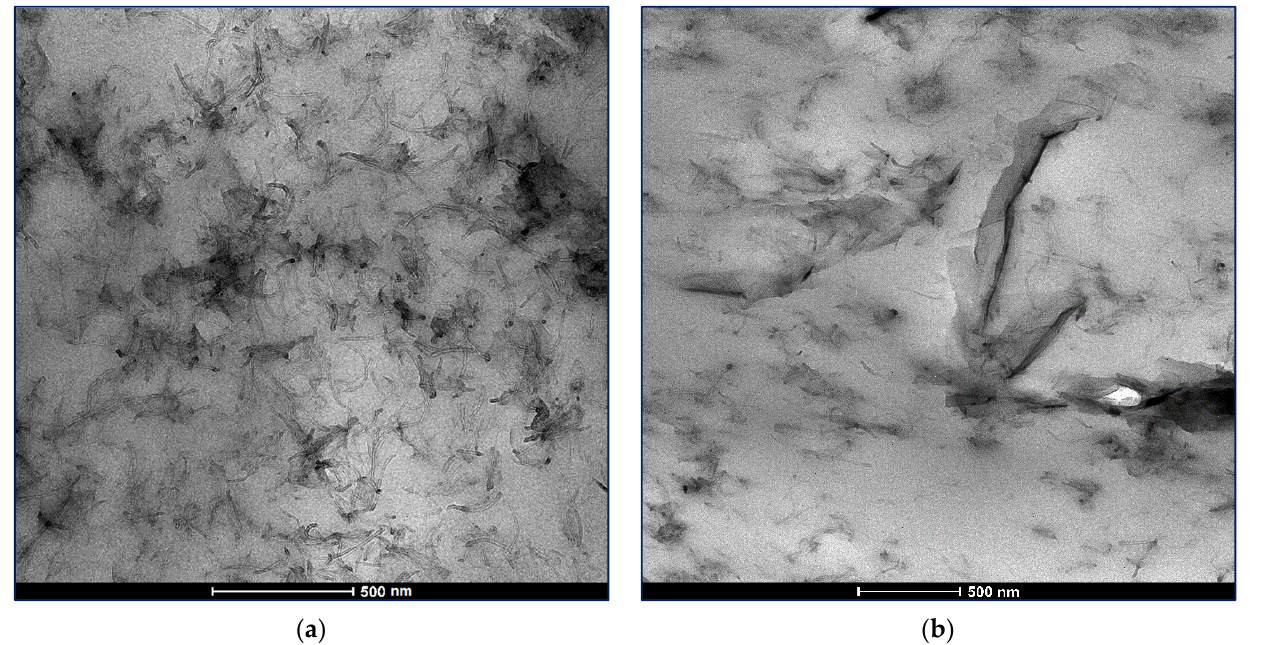
Figure 11. TEM micrographs of the bifiller nanocomposite films 1.5 wt%GNP4.5 wt%MWCNT/PLA ( a ) and 4.5 wt%GNP1.5 wt%MWCNT/PLA ( b ). ( a ) and 4.5 wt%GNP1.5 wt%MWCNT/PLA ( b